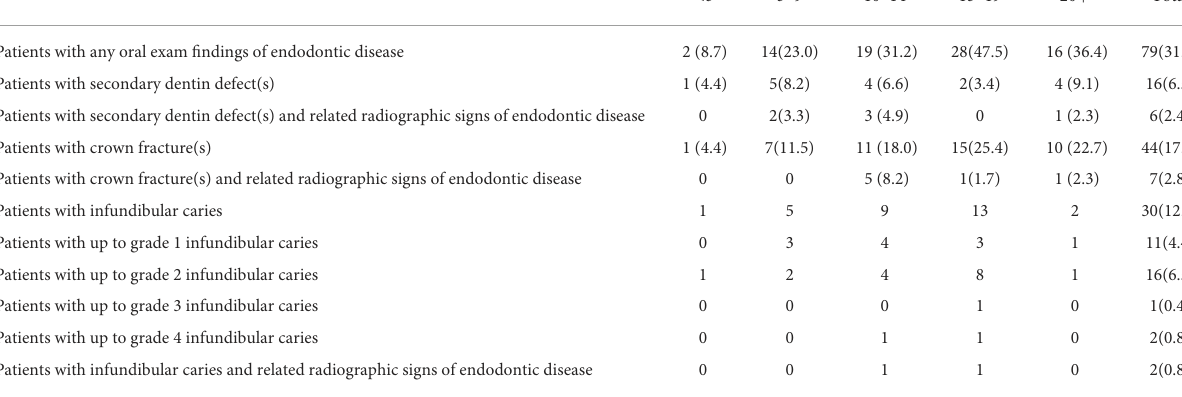
TABLE 5 Endodontic disease.